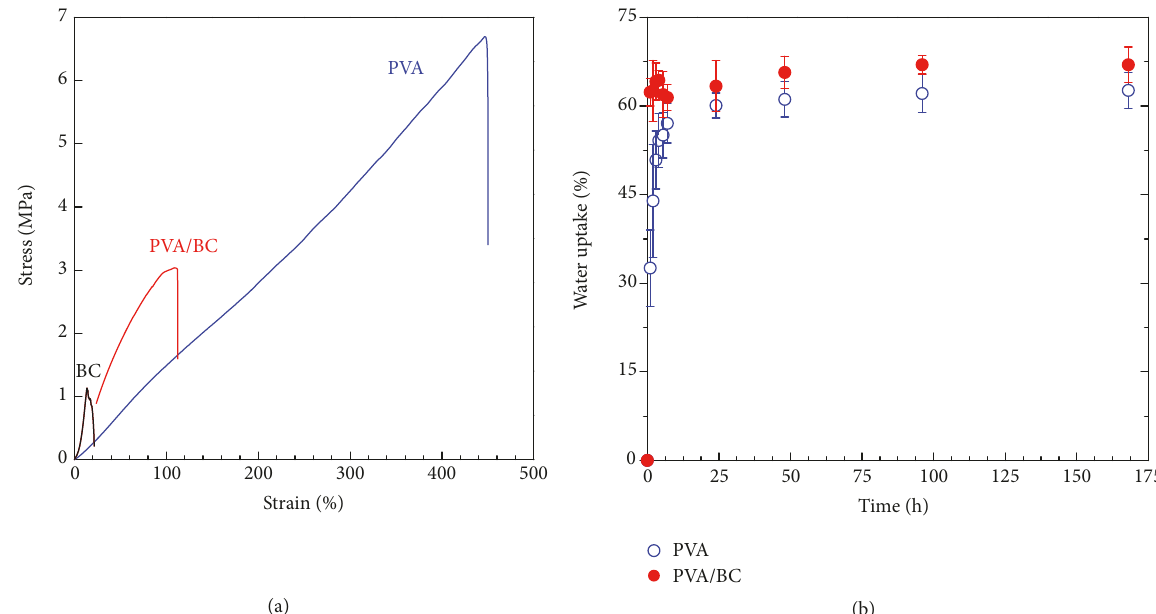
Figure 2: (a) Biomaterial strain-stress curves under uniaxial tension in the wet state for BC, PVA, and PVA/BC nanocomposites, as indicated. (b) Kinetics of water uptake for PVA and PVA/BC nanocomposite (biomaterial rehydration profiles). The water content was measured gravimetrically. Table 1: Mechanical properties of biomaterials in the wet state: Young’s modulus and tensile strength under uniaxial stress (the test was performed in air). Included is also the biomaterial swelling, swelling (%), water content (wt.%), time to reach equilibrium (h), and wet thickness (mm). Biomaterial swelling, swelling as percentage, was calculated according to (1). The time to reach swelling equilibrium was determined when mass changes of less than 1 wt.% were recorded. The wet thickness is reported in millimetres.